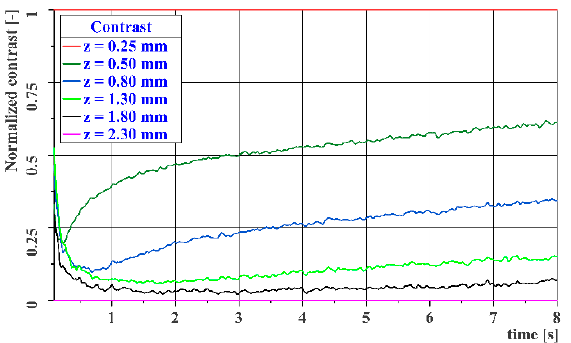
Figure 12. Image contrast curves for the reference gauge.